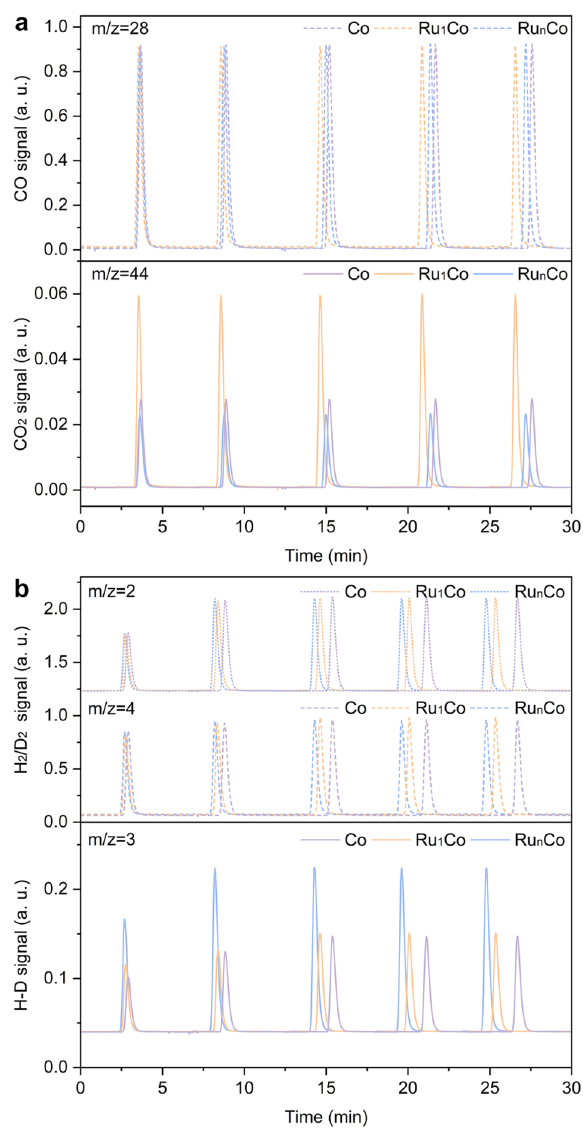
Fig. 5 | Pulse chemisorption experiments using different catalysts. a CO pulse pro fi le with CO (m/z=28) and CO 2 (m/z=44) signals. b H 2 isotopic pulse pro fi le with H 2 (m/z=2), D 2 (m/z=4) and HD (m/z=3)